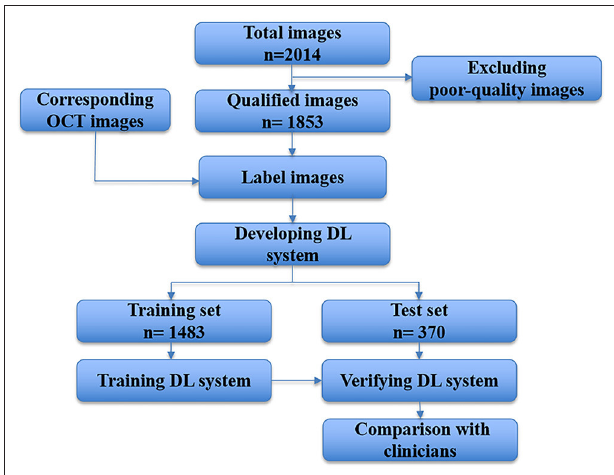
FIGURE 4 | Flow chart showing the AI system development and evaluation based on fundus photographs. DL, deep learning; OCT, optical coherence tomography.